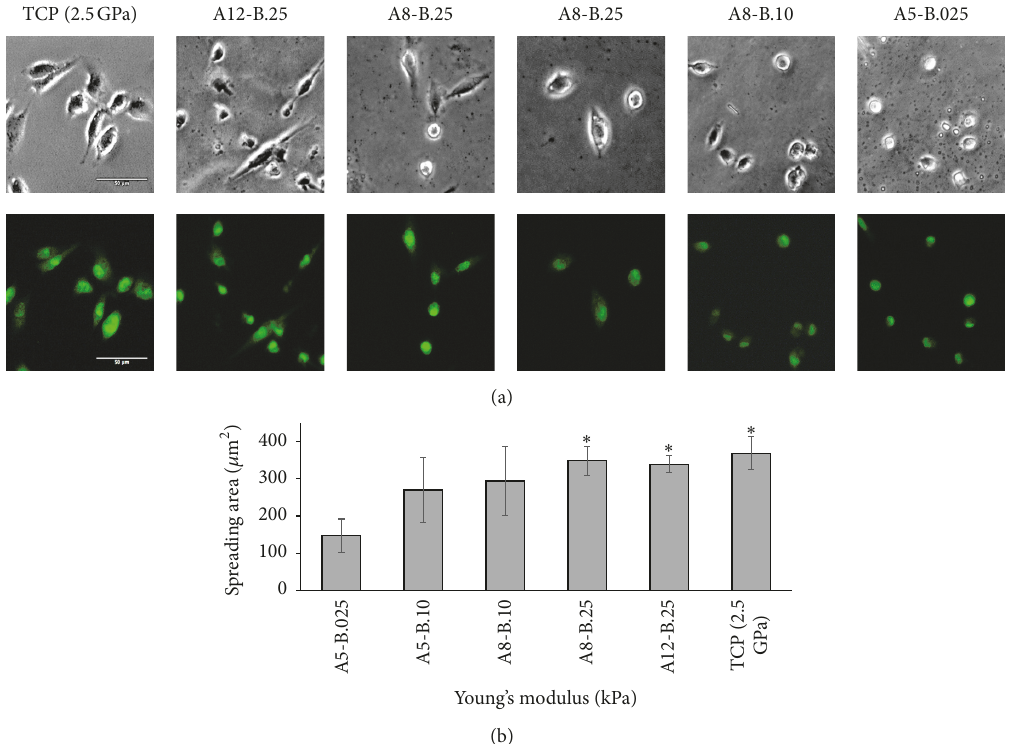
Figure 7: Cell morphology after 24 h of culture on collagen-coated PAA gels of varying stiffness. (a) Phase contrast (upper panel) and fluorescent (lower panel, acridine orange staining) images of MDA-MB-231 cells seeded on PAA gels of different stiffness. (b) Spreading area of MDA-MB-231 cells seeded on PAA gels of different stiffness. Asterisks designate significant differences from the 1kPa hydrogel ( 𝑝 < 0.05 , 𝑛 = 3